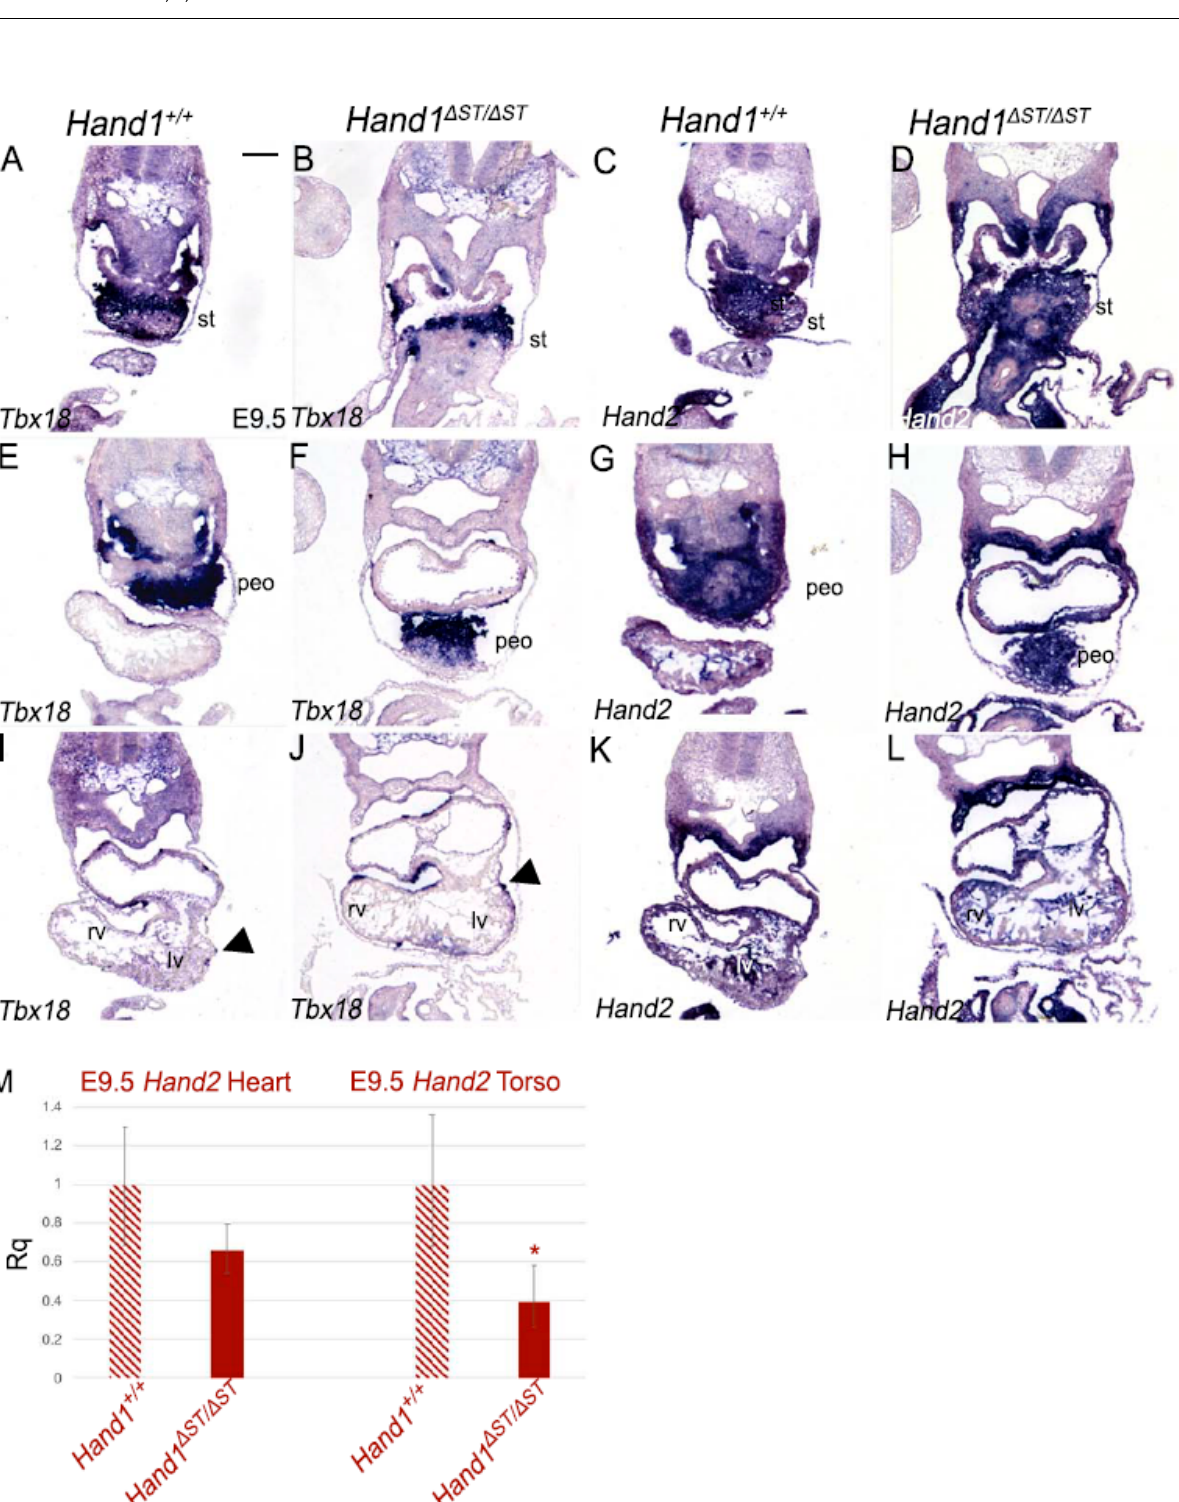
Figure 4. Hand2 expression in Hand1 Δ ST/ Δ ST Embryos. ( A – L ) Section in-situ hybridization at E9.5 for Tbx18 and Hand2 mRNA in Hand1 +/+ and Hand1 Δ ST/ Δ ST embryos. Arrowheads indicate Tbx18 expressing cells migrating over the heart to form the epicardium. st, septum transversum; peo, proepicardial organ; rv, right ventricle; lv, left ventricle. n = 3 for all genotypes. Scale bar 100 μ m. ( M ) qRT-PCR at E9.5 for Hand2 expression in heart, and torso (dissected to exclude the heart, but with PEO and ST intact) in Hand1 +/+ and Hand1 Δ ST/ Δ ST embryos (* indicates p ≤ 0.01). n = 9 embryos, pooled. Error bars represent the high and low range of replicate cycle reads within each primer set.